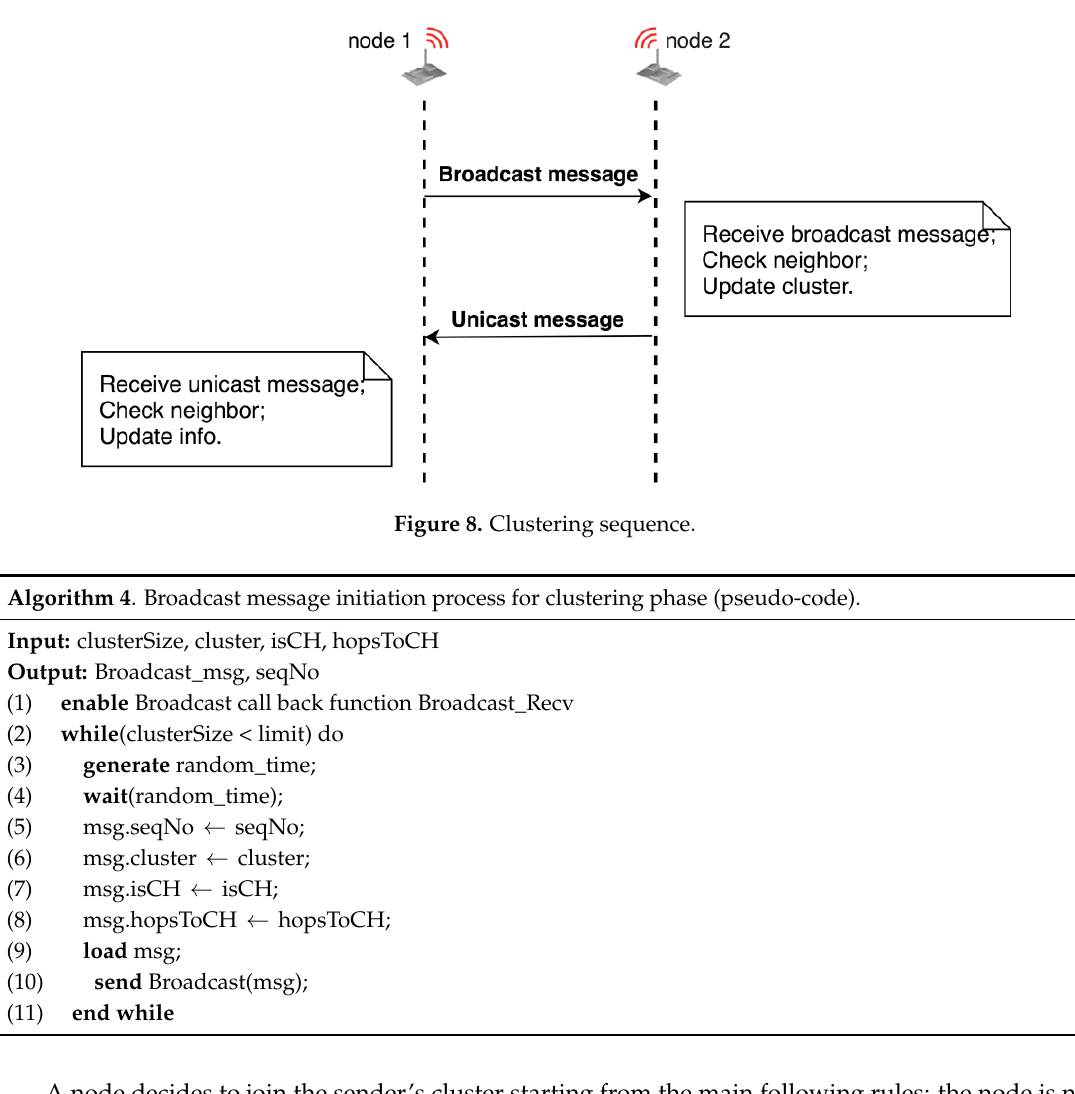
Algorithm 5 . Broadcast message receiving process for clustering phase (pseudo-code).